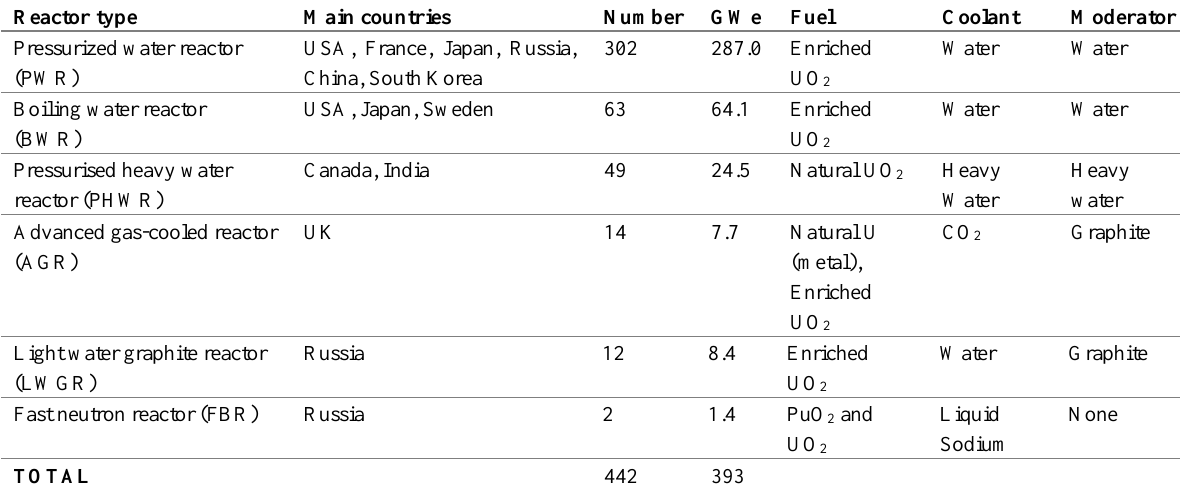
Table 1: Nuclear power plants in commercial operation or